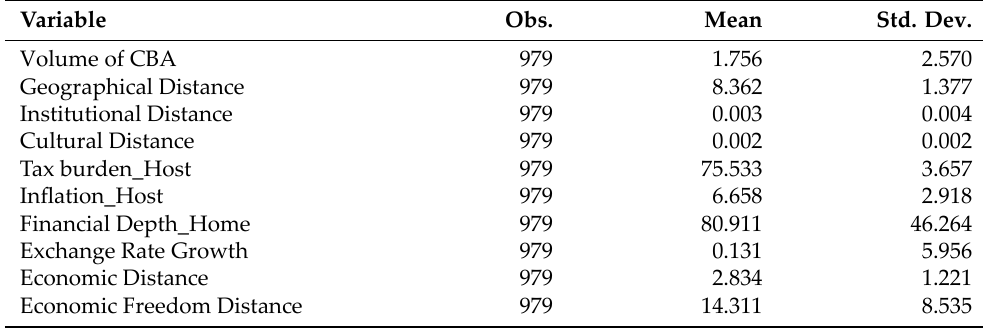
Table 2. Summary statistics of all the variables under the study.